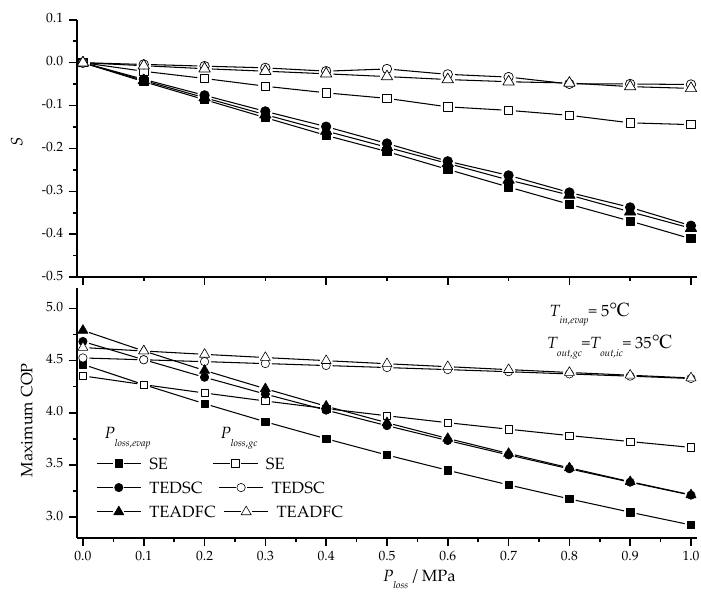
Figure 7. Sensitivity of maximum COP to pressure losses through gas cooler and evaporator.